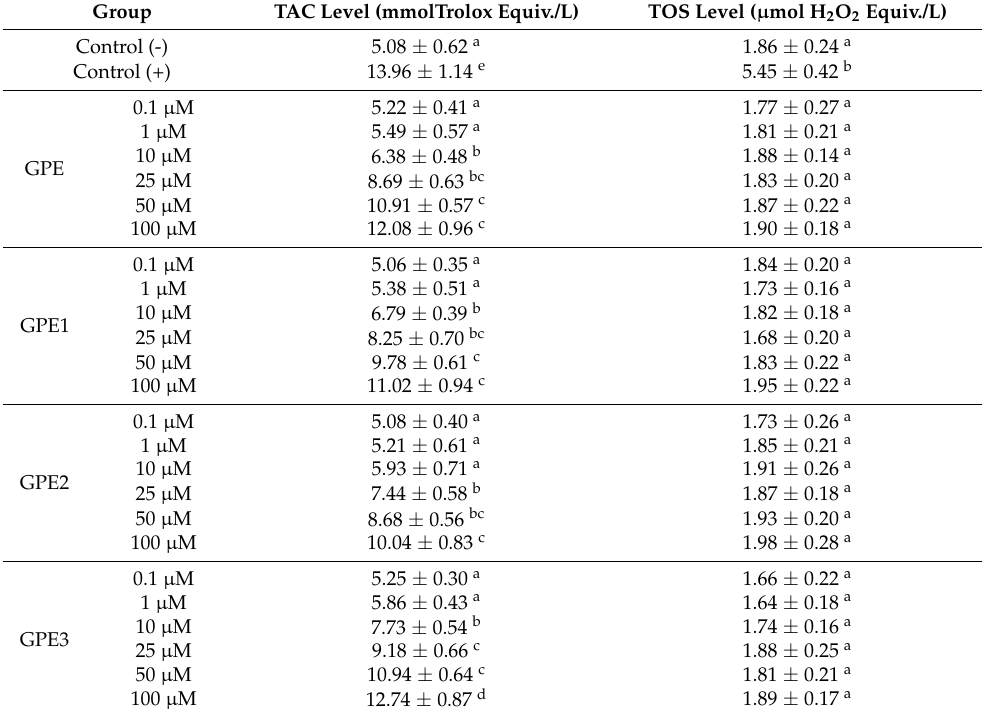
Table 3. The effects of GPEs on TAC and TOS levels in cultured differentiated SH-SY5Y cells. Statistical analysis was performed using one-way ANOVA followed by Tukey’s post-hoc test. Means (n = 5) with the same letter in the same column are not significantly different at p = 0.05.